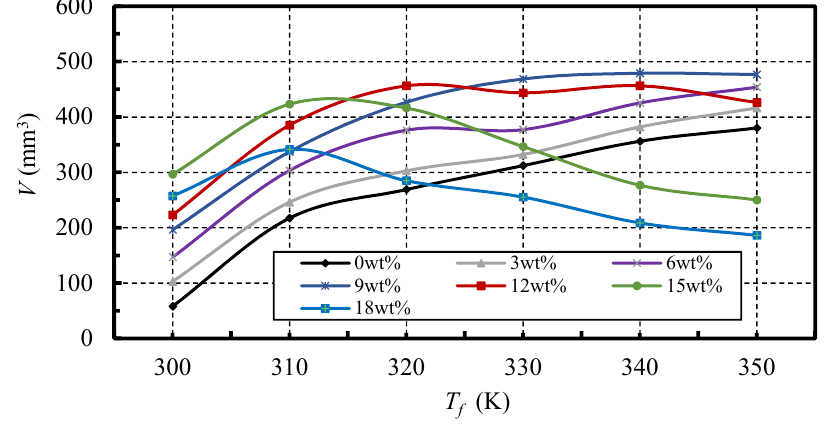
Figure 10. Rock erosion characteristics under various fluid temperatures.